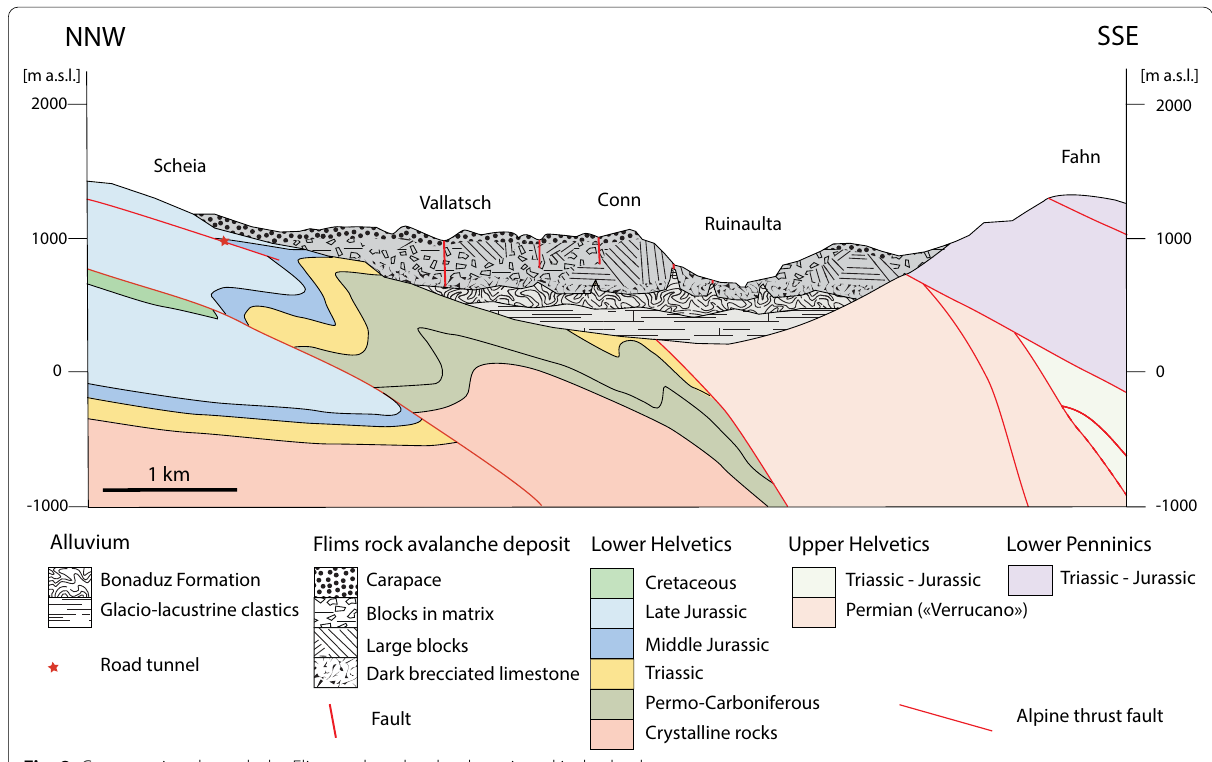
Fig. 8 Cross-section through the Flims rock avalanche deposit and its bedrock